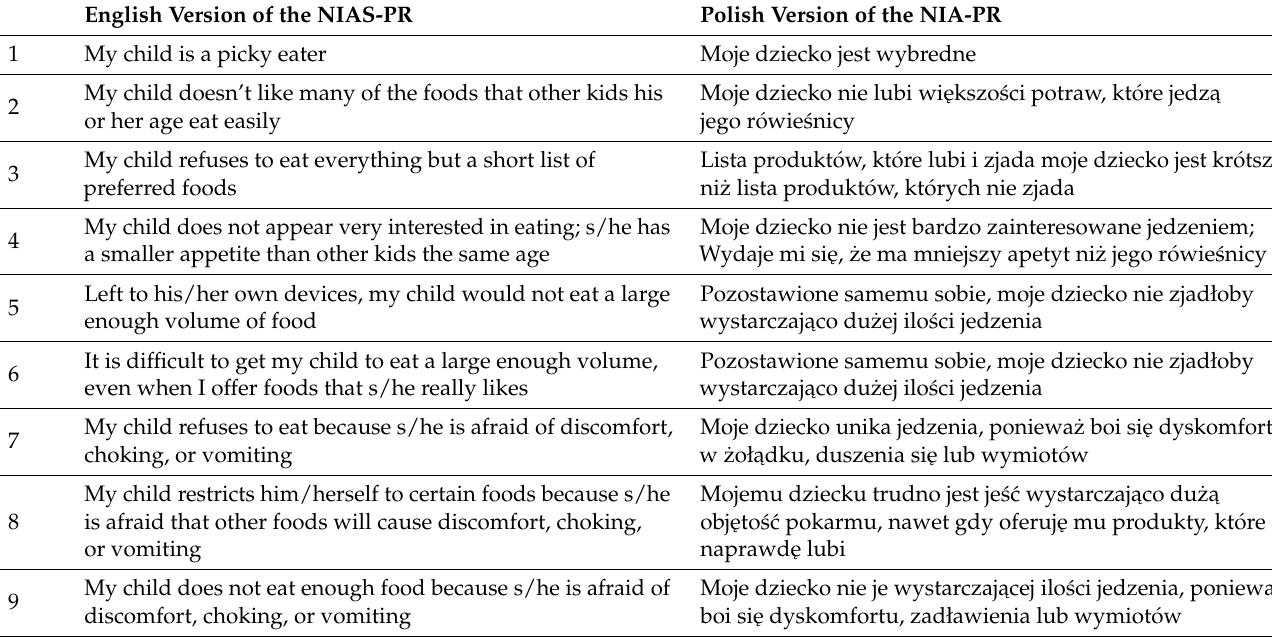
Table 2. NIAS-PR: English and Polish